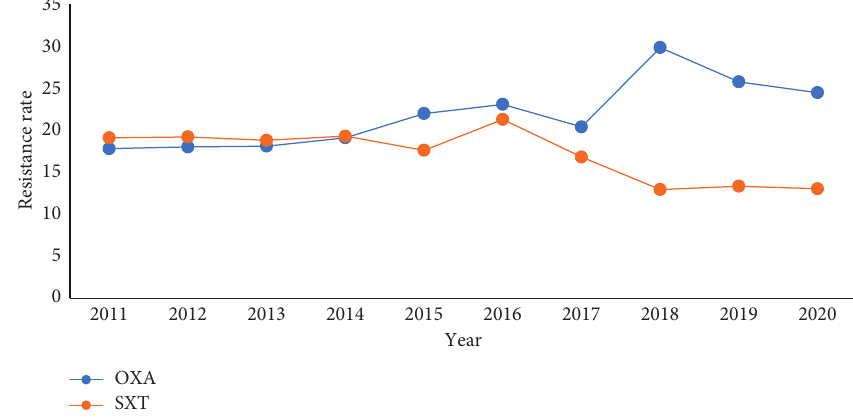
Figure 15: Changes in drug resistance of S. aureus from 2011 to 2020 (%).